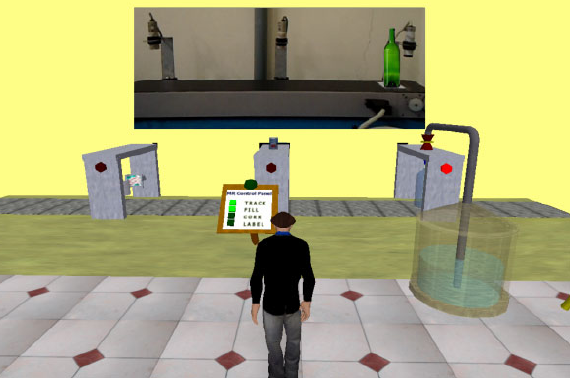
Figure 7. Real and virtual bottling plant integration